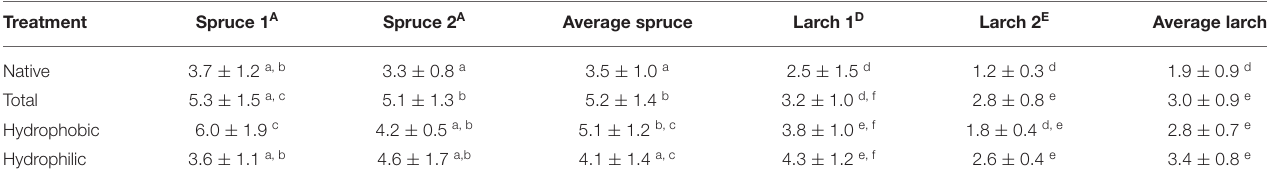
TABLE 4 | Average weight loss percentage and associated standard deviations of sticks of two clones of Norway spruce and Kurile Larch after different extraction treatments. Treatment Spruce 1 A Spruce 2 A Average spruce Larch 1 D Larch 2 E Average larch Native 3.7 ± 1.2